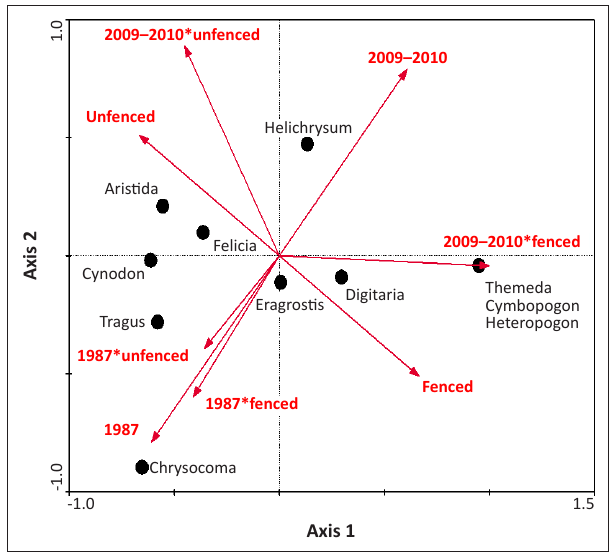
The species are, (1) annual grass: Aristida congesta ; (2) creeping grasses: Cynodon incompletus and Tragus koelerioides ; (3) bunch grasses: Cymbopogon pospischilii , Digitaria eriantha , Eragrostis curvula , Heteropogon contortus , Themeda triandra and (4) dwarf shrubs: Chrysocoma ciliata , Felicia fascicularis and Helichrysum dregeanum . Eigenvalues for axes 1 and 2 are 0.577 and 0.052, respectively. The sum of all eigenvalues is 1.401 and the sum of all canonical eigenvalues is 0.629. The arrows contrast the treatments (fenced, unfenced) and survey years (1987 and 2009–2010). The asterisks indicate interactions between treatments and survey years. The locations of the species indicate their association with the treatments and survey years. FIGURE 3: Ordination diagram of the canonical correspondence analysis.